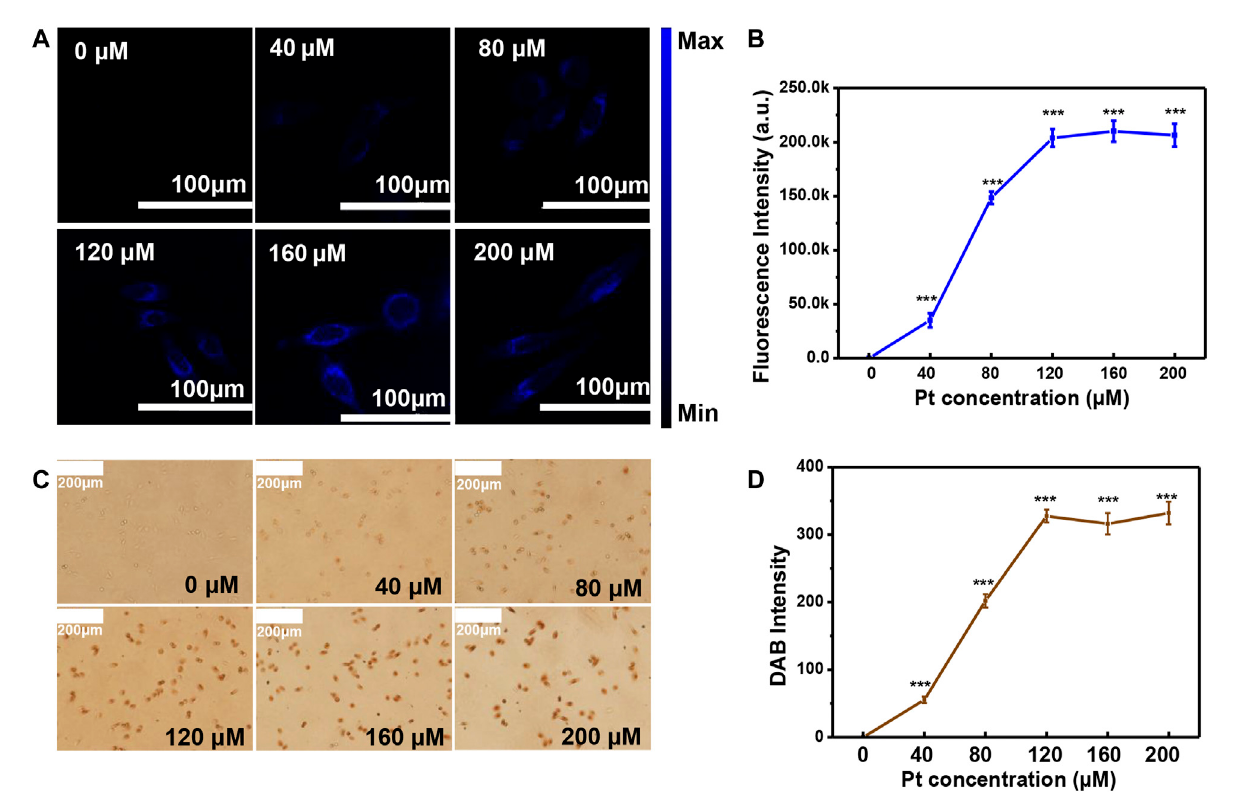
FIGURE 5 OptimizationofthePtclusterconcentrationincellculturemedium. (A) Confocallaserscanningmicroscopy(CLSM)imagesofSiHacellsexposedto different concentrations of Pt clusters for 60 min. (B) Corresponding fl uorescence intensity analyzed by ImageJ software. (C) Images of the brown color cells when DAB are catalyzed by Pt clusters for 60 min. (D) Corresponding cell brown intensity analyzed by ImageJ